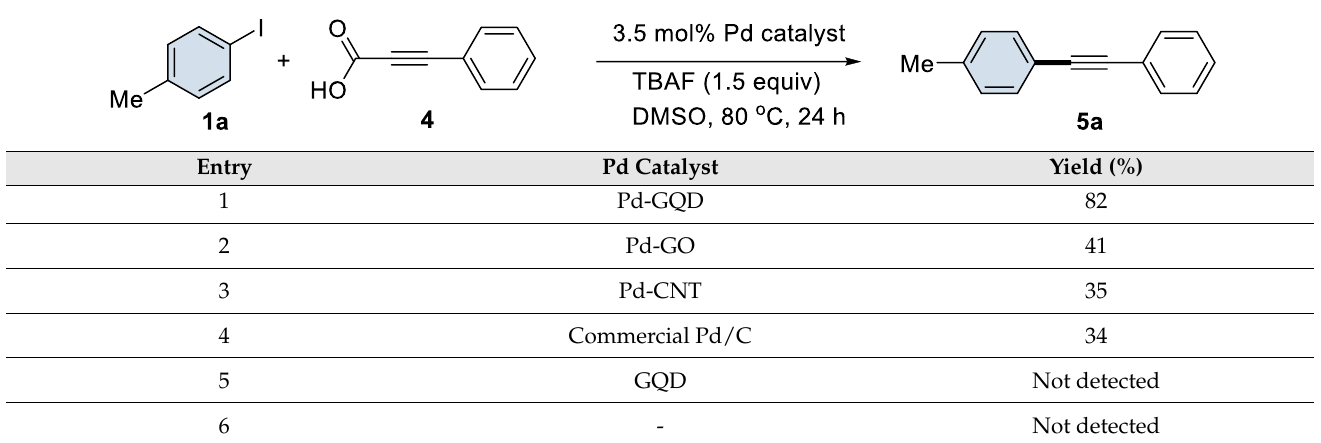
Table 2. Catalytic activities in the Pd-catalyzed decarboxylative cross-coupling reactions.